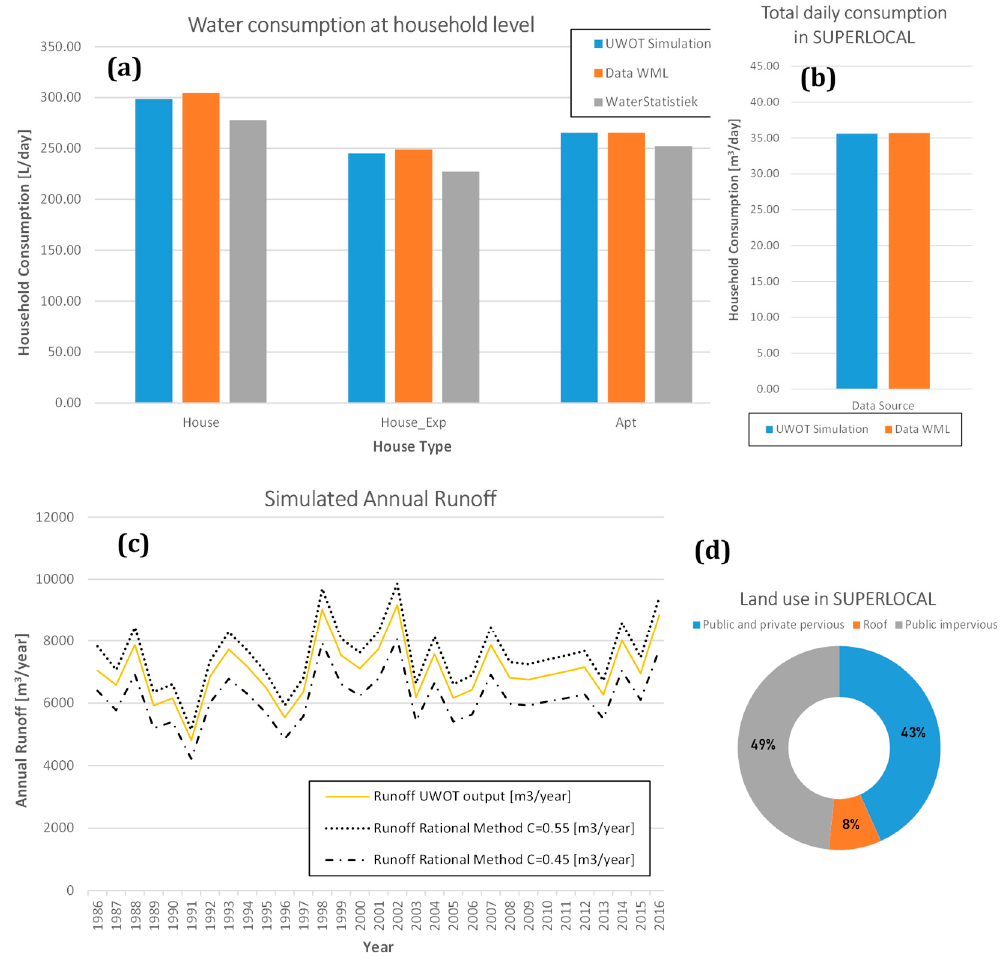
Figure 6. UWOT model validation results.